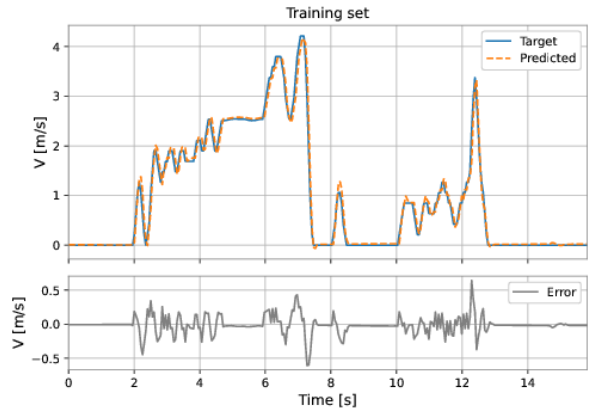
Figure 53. MLP’s predictions on the training set.